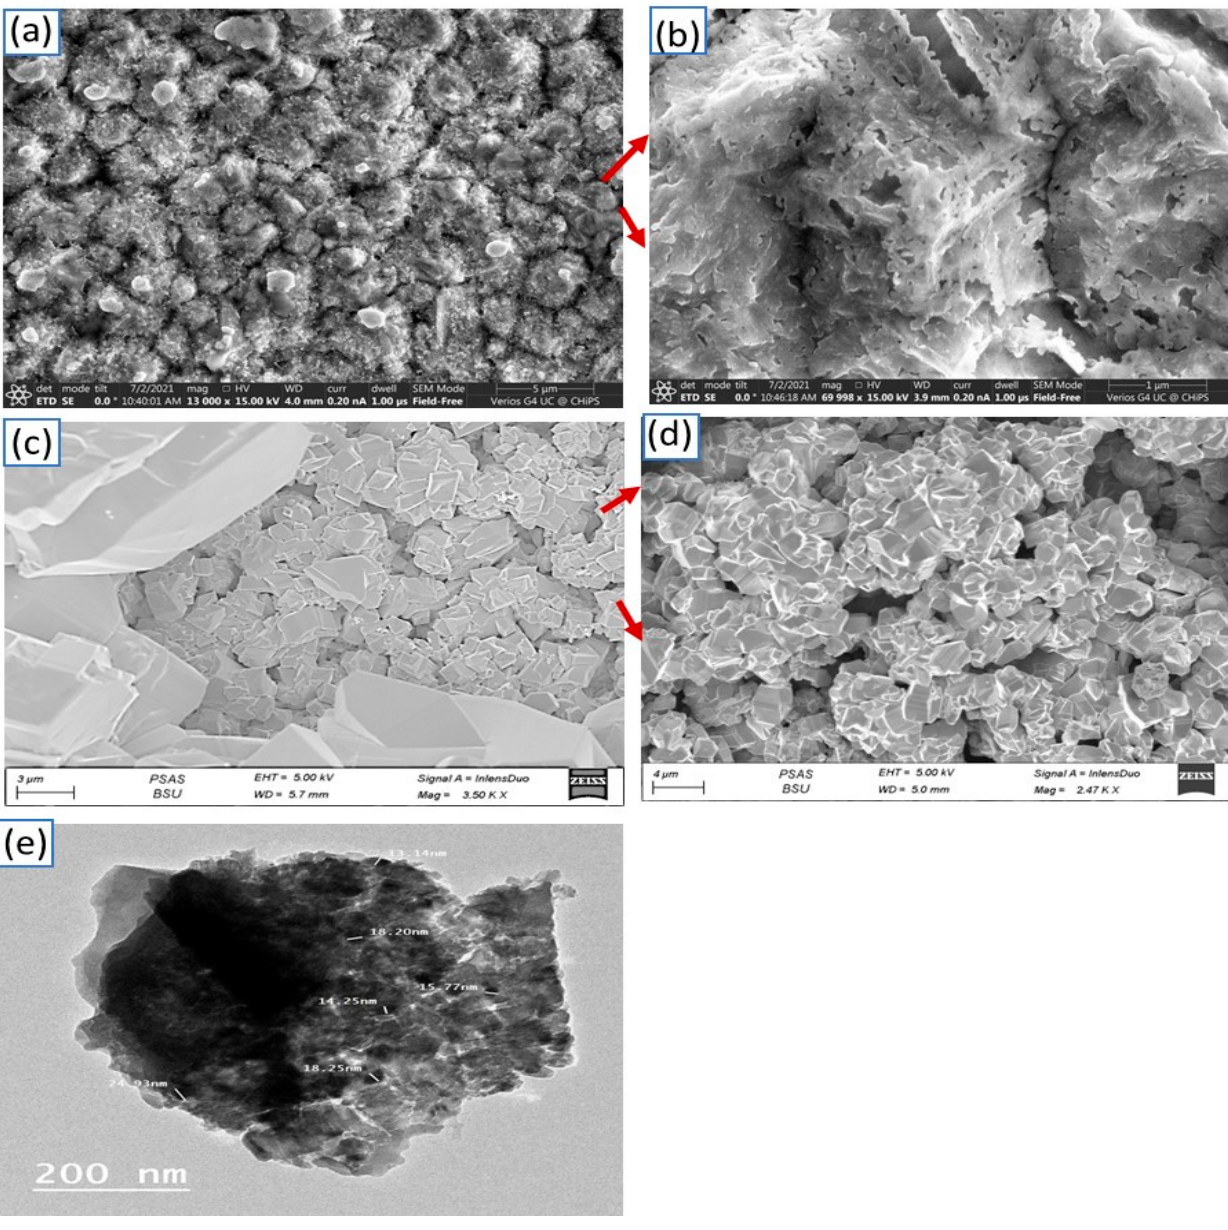
Figure 3. SEM of ( a , b ) CuO and ( c , d ) CuFeO 2 . ( e ) TEM of CuFeO 2 /CuO. The optical reflectance of CuO and CuFeO 2 materials were determined from the optical characterizations for the samples, as shown in Figure 4. The CuO and CuFeO 2 materials had almost the same behavior, but the reflectance of CuFeO 2 had a more enhanced behavior. This indicates the elevated absorbance in UV, Vis, and near-IR regions. The bandgap values were enhanced after the CuFeO 2 formation, in which CuO and CuFeO 2 materials had bandgap values of 1.38 and 1.35 eV, respectively. The bandgap values were calculated using Kubelka–Munk equations (Equations (1) to (3)) [26]. These equations depend on the scattering factor (S), reflectance (R), and the molar absorption coefficient (K). The